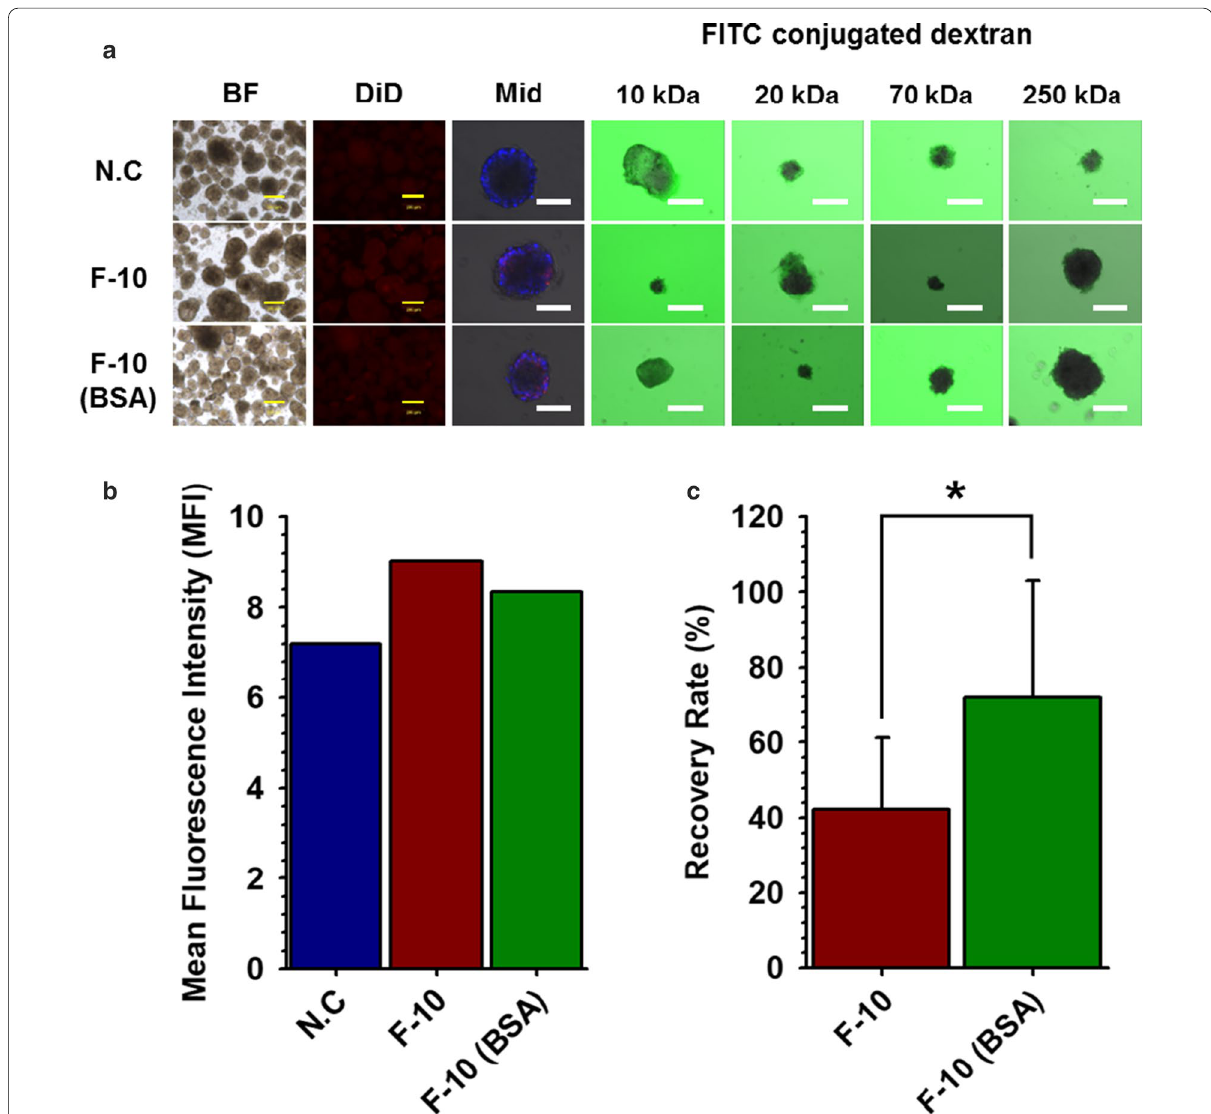
Fig. 3 Comparisons of coating efficiency after 0.25% BSA addition in nano‑encapsulation reaction buffers for increase the recovery rate. a Coating efficiency and selective permeability of nano‑encapsulated NPCCs with NHS‑PSome in F‑10 or F‑10 with 0.25% BSA (BF; bright field, Mid; middle image using CLSM of DiD‑conjugated NHS‑PSome nano‑encapsulated NPCCs, FITC‑conjugated dextran; middle image using CLSM of FITC‑conjugated dextran in NHS‑PSome nano‑encapsulated NPCCs). Blue in Mid represent the cell through DAPI staining. Scale bars are 200 (BF and DiD) and 100 (Mid and FITC‑conjugated dextran) μm; b MFI of nano‑encapsulated NPCCs using DiD‑conjugated NHS‑PSome; c Recovery rate of NPCCs after nano‑encapsulation in F‑10 ( n 12) or F‑10 with 0.25% BSA ( n 12). Data represent the mean S.D. * p < 0.05 versus = = ±